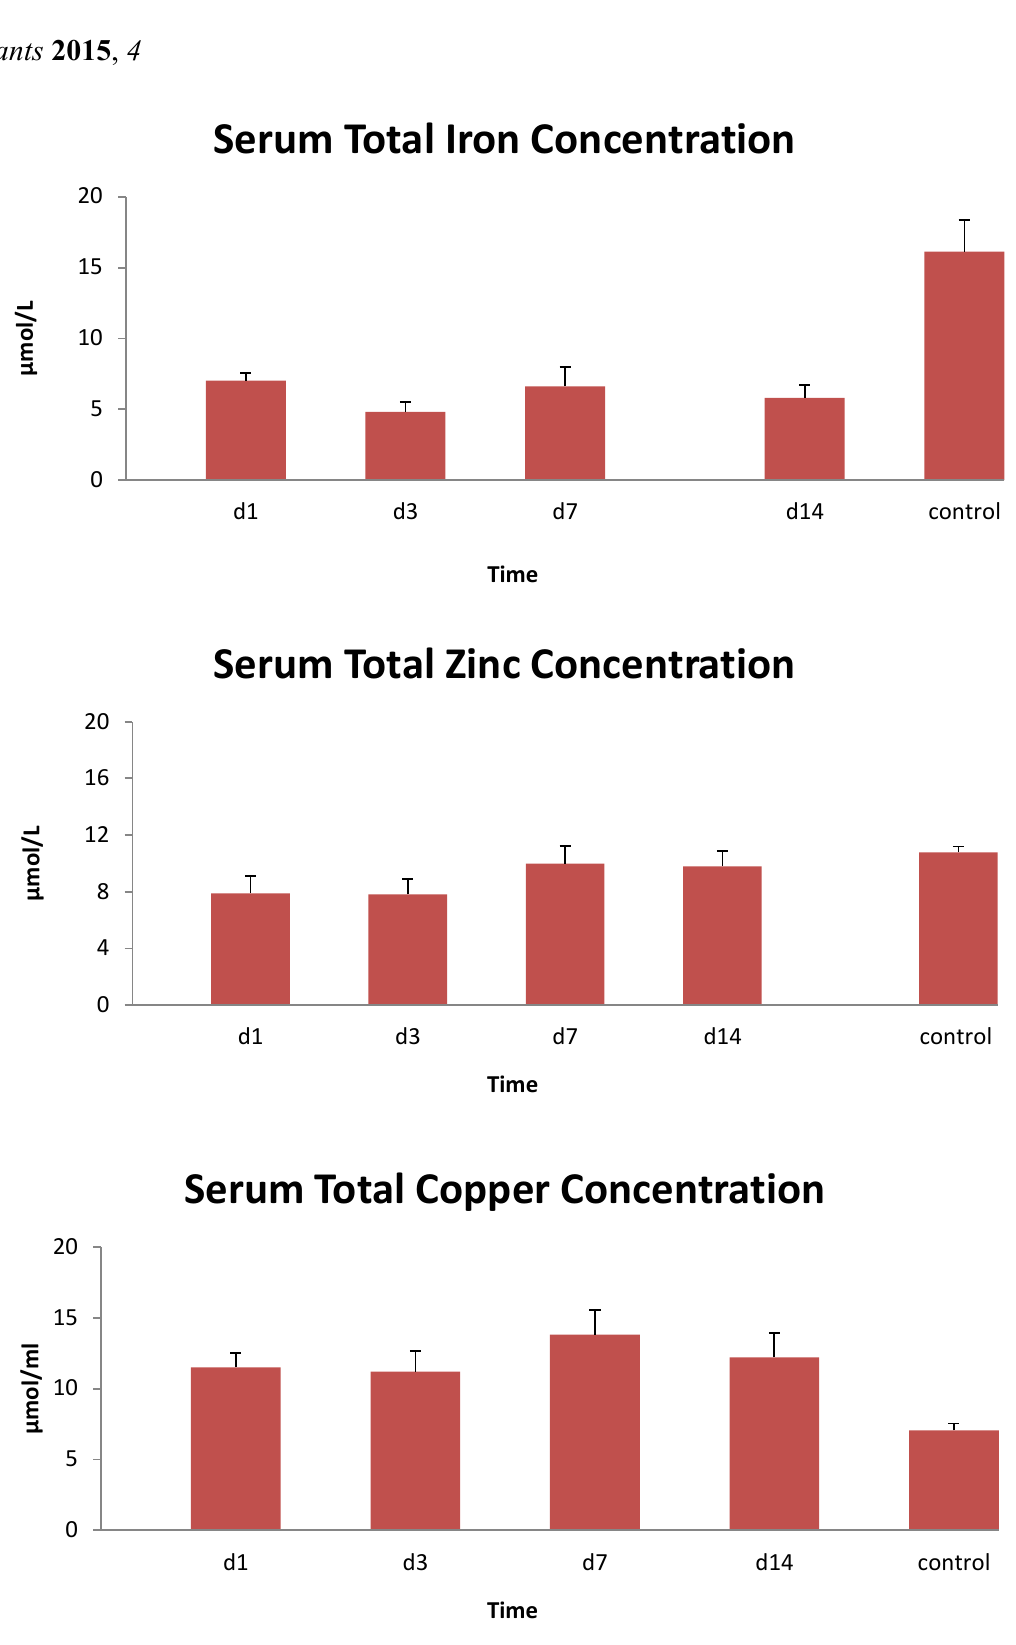
Figure 2. Total serum iron, zinc and copper concentrations in 10 thermally injured patients. Data expressed as mean ± SE. Control data were from historic normal